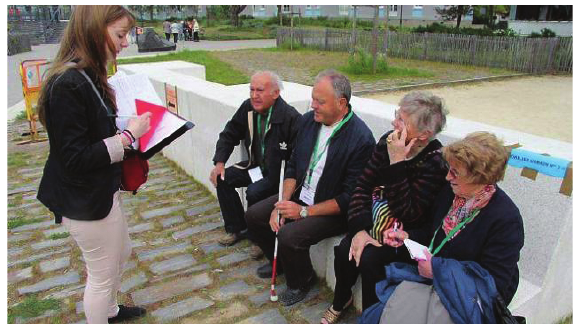
Figure 8. Public benches tested by inhabitants. Source: Ouest-France